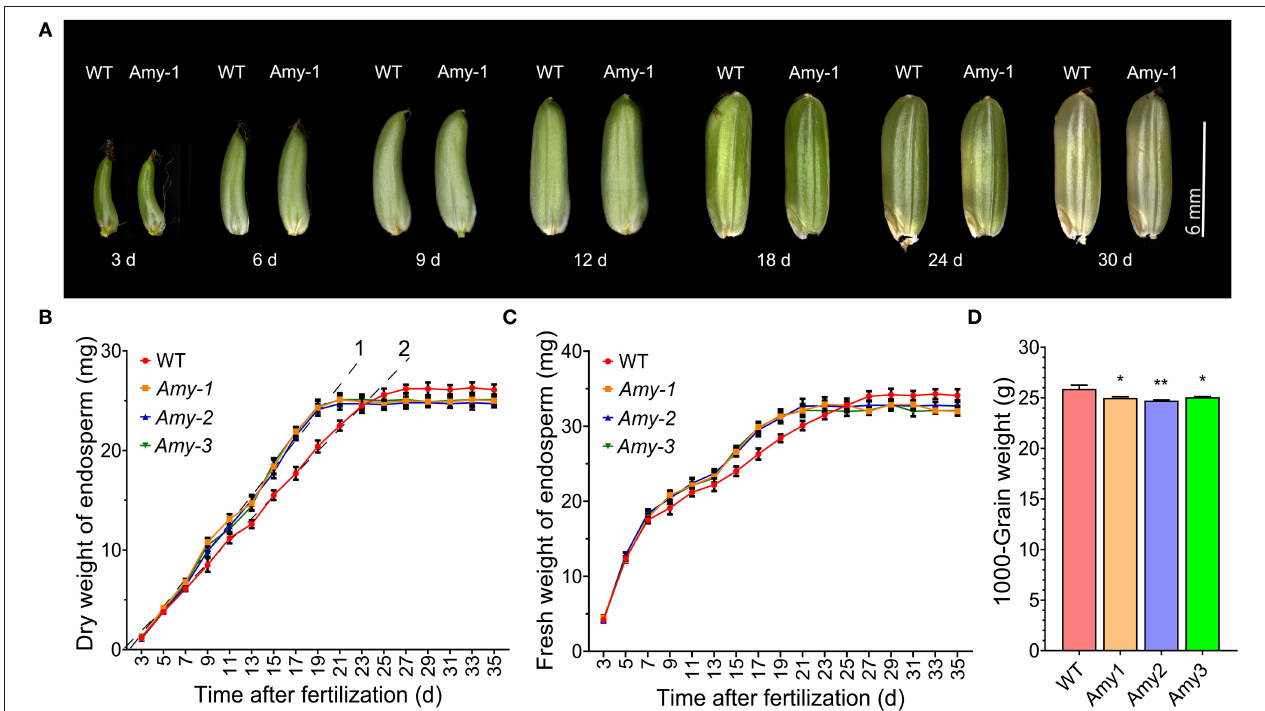
FIGURE 2 | The changes in endosperm weight and grain-filling rate characteristics during the grain filling period. (A) Growth and the change of grain morphologies. Scale bar = 6mm. (B,C) Dry and fresh weight of endosperm changes. (D) 1,000-Grain weight of the transgenic lines and WT. Values are given as the mean ± SD. * P < 0.05; ** P < 0.01 compared with the wild type using Student’s t